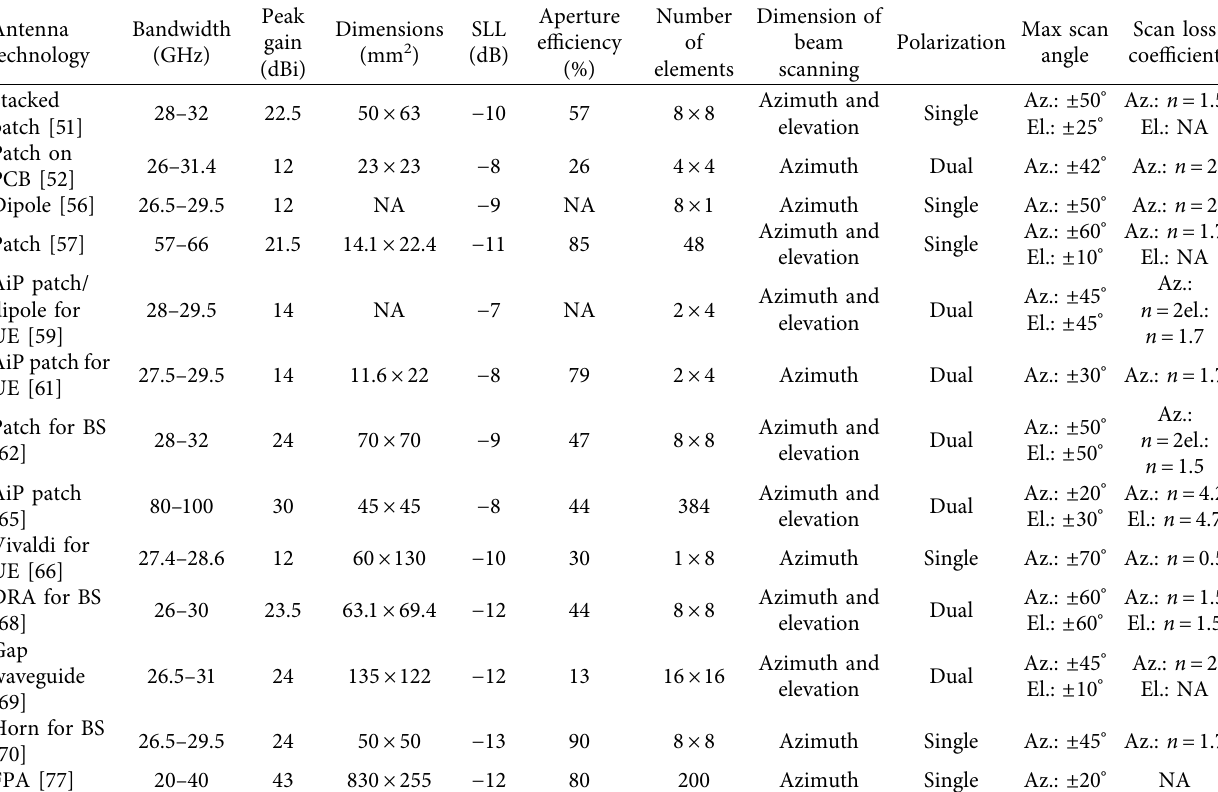
Table 2: State of the art of antenna arrays for PtM mm-wave wireless